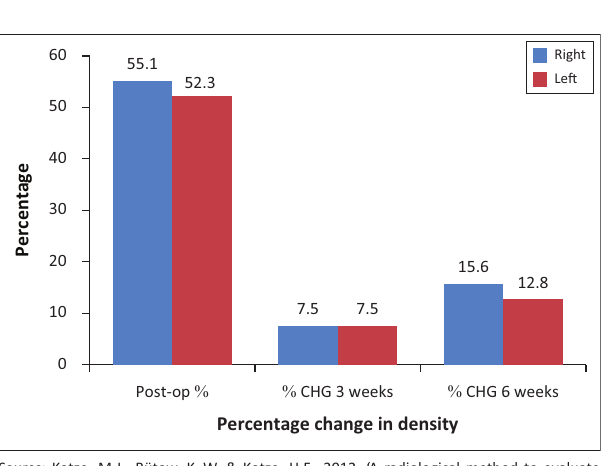
FIGURE 5: Percentage change in density after 3 and 6 weeks.